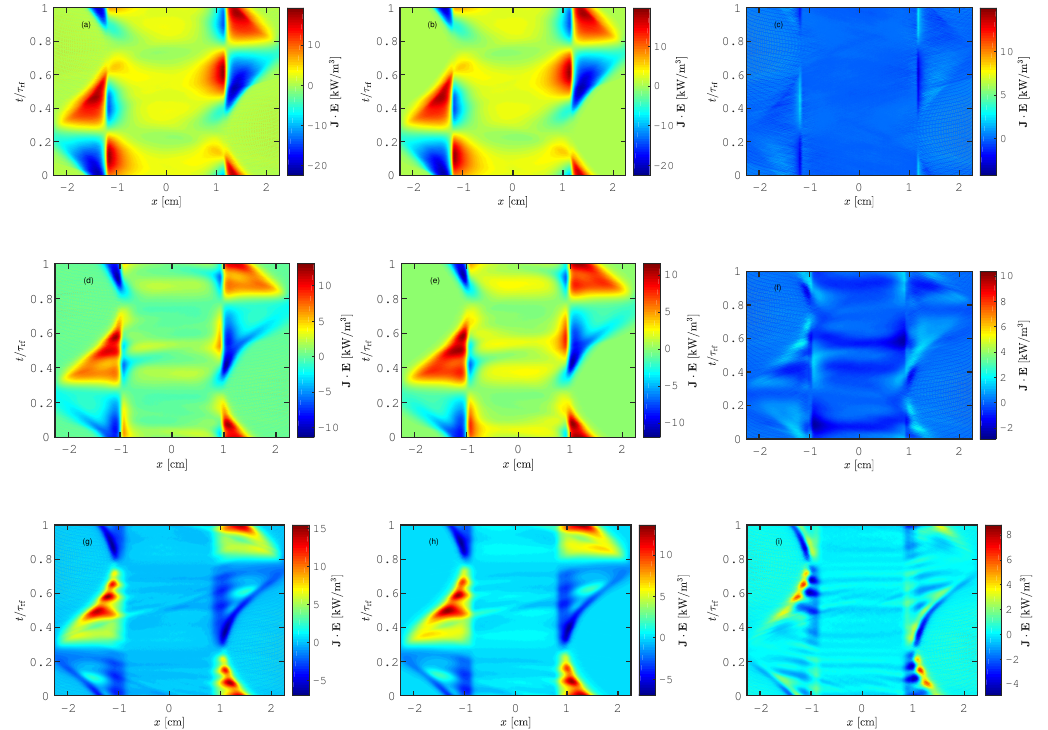
Figure 4. The spatio-temporal behavior of the electron power absorption for a parallel plate capacitively-coupled oxygen discharge at 10 mTorr for ( a ) γ see ( E ) and ( b ) γ see = 0.0, ( c ) the difference between γ see ( E ) and γ see = 0.0, at 25 mTorr, for ( d ) γ see ( E ) and ( e ) γ see = 0.0, ( f ) the difference between γ see ( E ) and γ see = 0.0, at 50 mTorr for, ( g ) γ see ( E ) and ( h ) γ see = 0.0, and ( i ) the difference between γ see ( E ) and γ see = 0.0 with a surface quenching coefficient for the singlet metastable molecule O 2 ( a 1 ∆ g ) as γ wqa = 0.0001, r = 0.0, and a gap separation of 4.5 cm driven by a 222 V voltage source at a driving frequency of 13.56